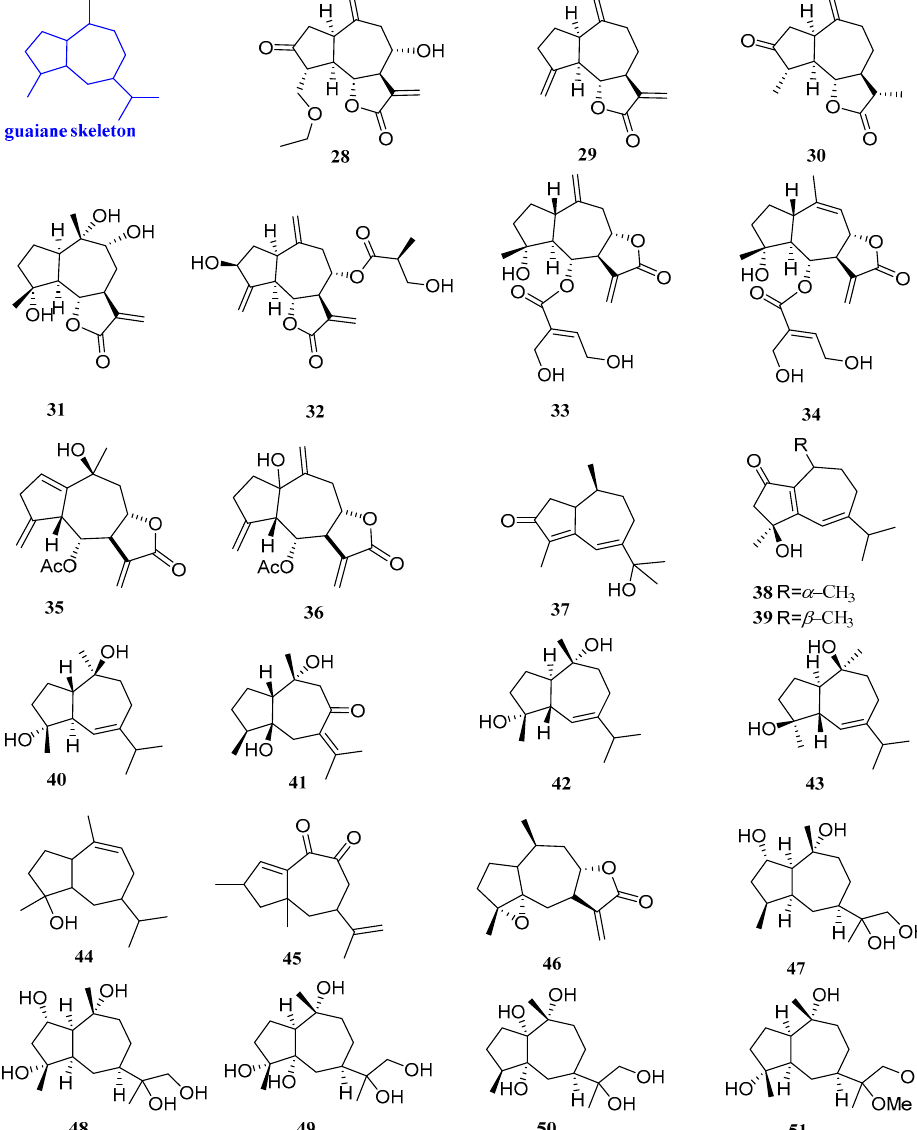
Figure 4. Structures of guaiane-type sesquiterpenoids 28 – 51 .